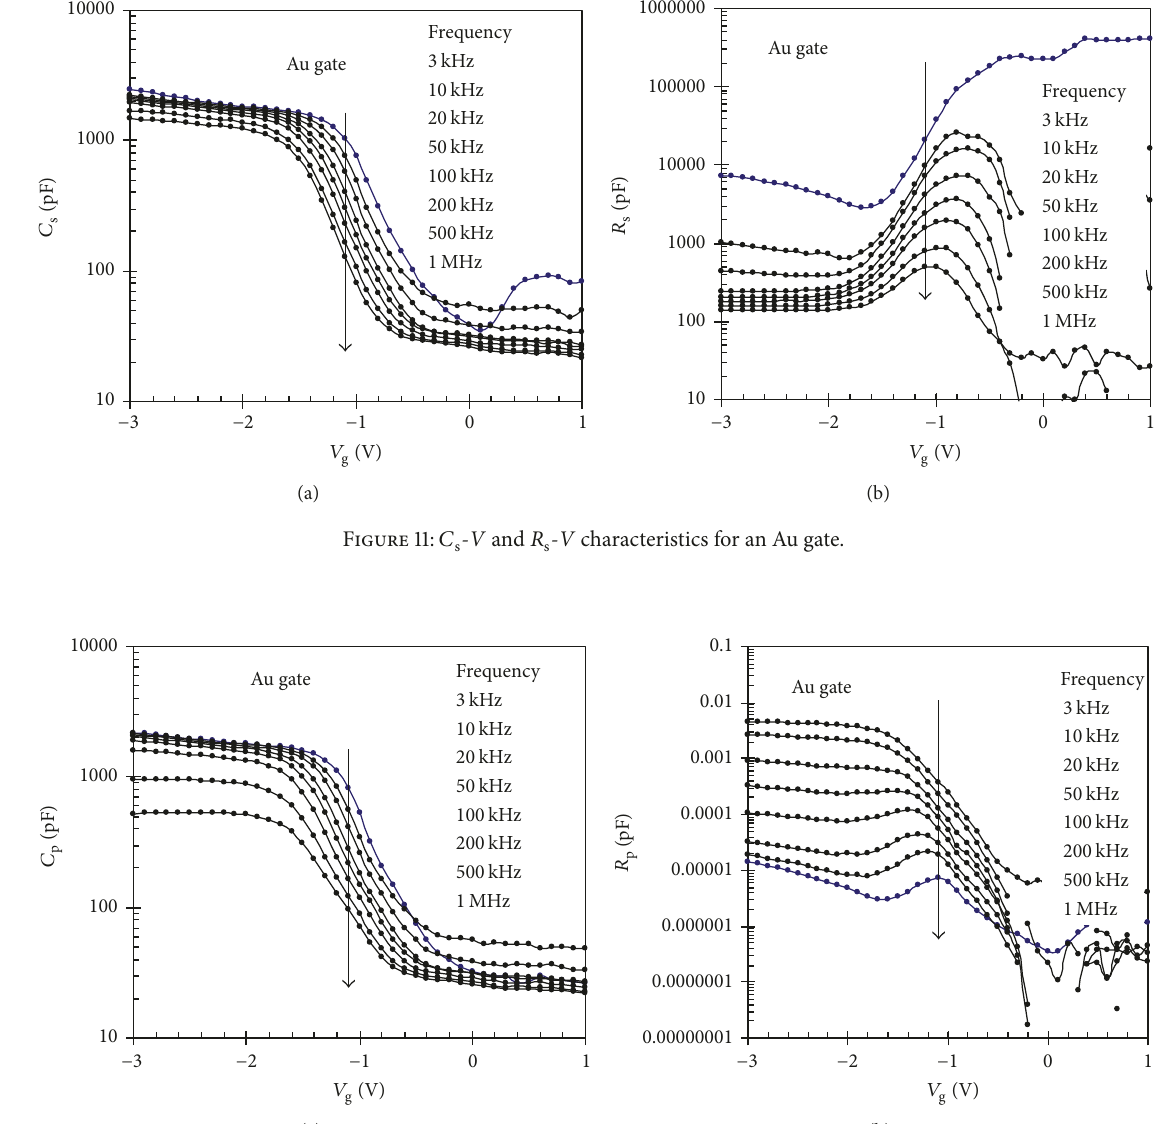
- V and 𝑅 - V characteristics for an Au p p